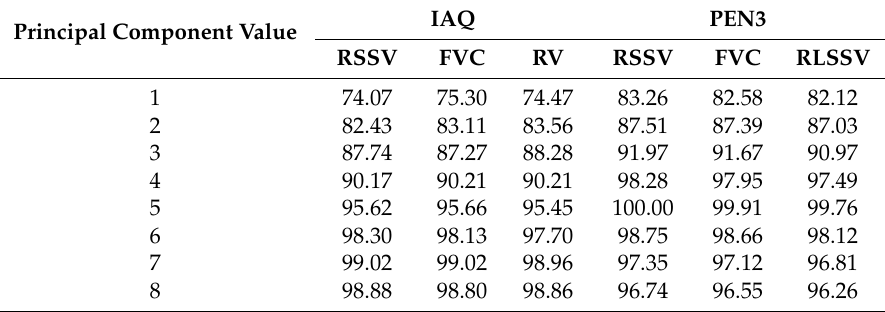
Table 6. Average PNN classification results in % for selecting principal component values in PCA for the IAQ and PEN3